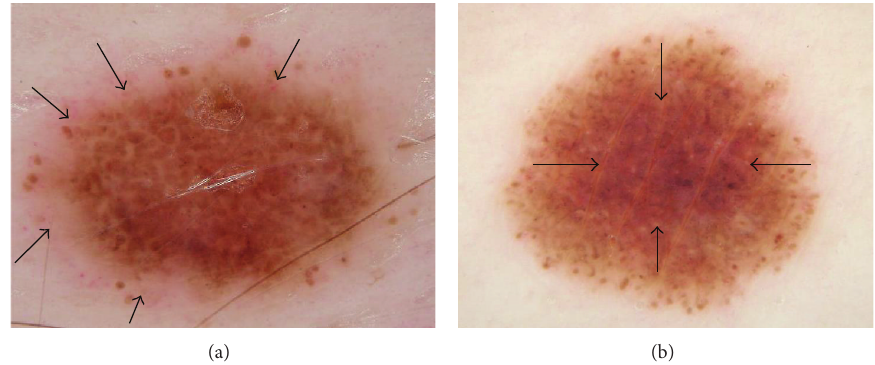
Figure 1: (a) In situ melanoma arising within a congenital lesion, 4 mm, abdomen, 34-year-old male. Peripheral pink with some eccentric pink centrally: in situ melanoma, 4mm wide, right abdomen, arising within a superficial compound congenital nevus; pink rim sign is present (arrows) just external to irregular network lacking pink. Note negative network and peripheral globules that are fairly uniform and symmetric. (b) Pink throughout lesion: benign nevus, not biopsied, 5 mm nevus on upper arm in 35-year-old female; pink is present at rim but is most prominent centrally (arrows). Pink rim sign is absent. Note similar architecture and symmetrically arranged globules in both lesions.